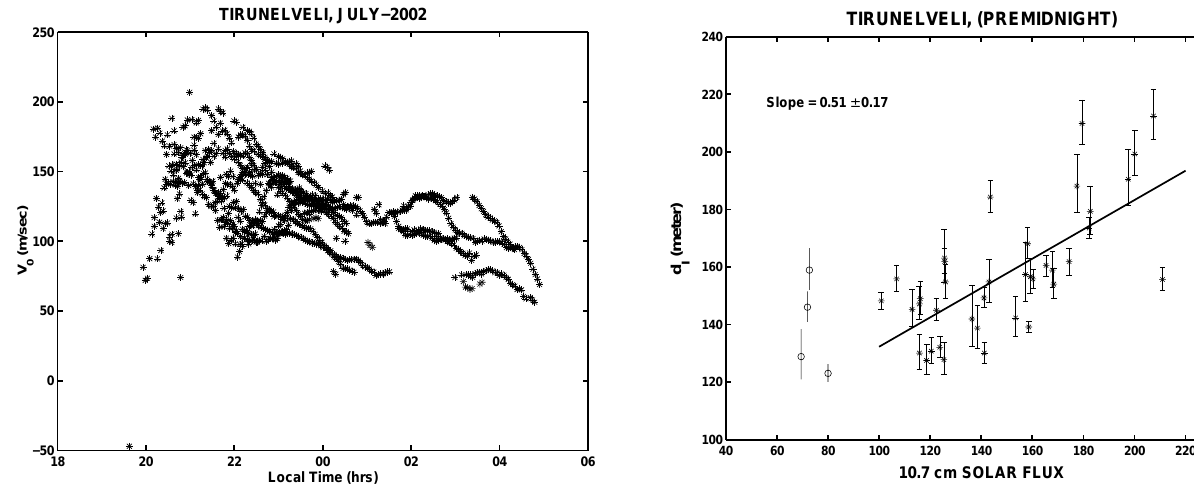
Fig. 4. Mass plot of average eastward drift, V 0 , of the ground scin- tillation pattern as a function of local time for July 2002.